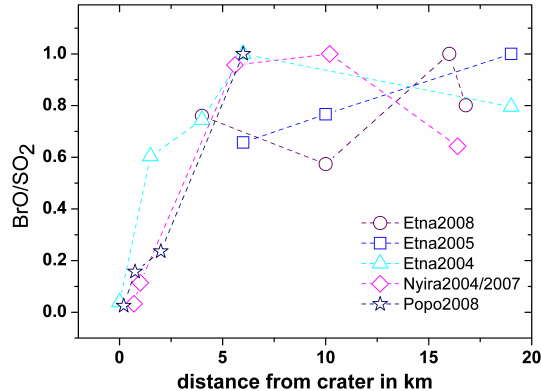
Fig. 3. BrO is formed by volcanic atmospheric-gas-interaction, but strong increase is (only) seen up to about 5km (young plume of some minutes). BrO/SO 2 ratios seem to move into a plateau after- wards. The BrO/SO 2 ratios were normalised for a better compari- son of the various sites. For more information, see